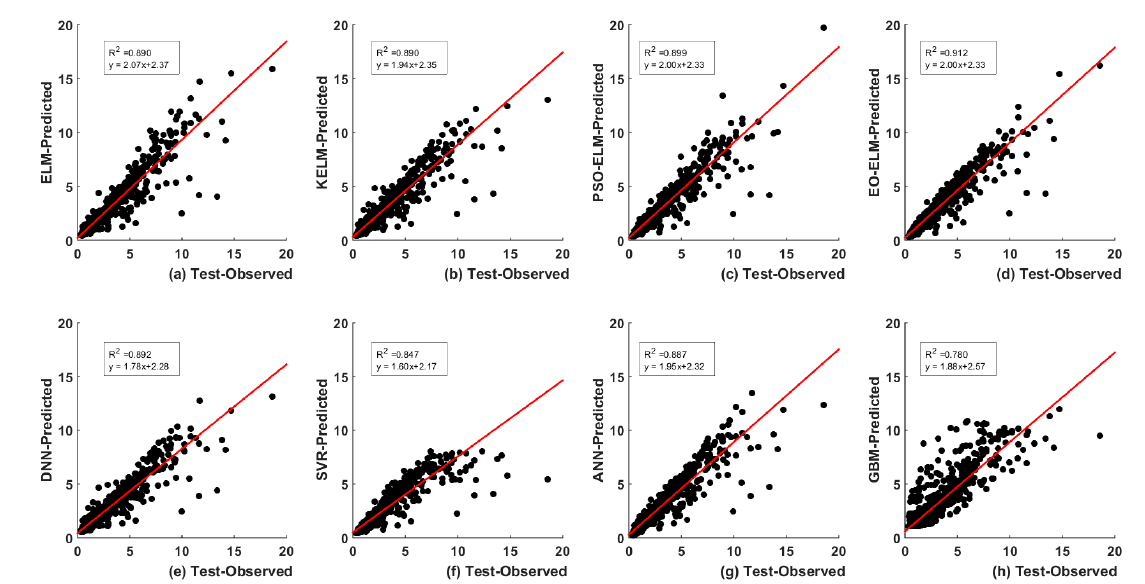
Figure 8. Prediction capability of the eight models in test case ( a ) ELM, ( b ) KELM, ( c ) PSO-ELM, ( d ) EO-ELM, ( e ) DNN, ( f ) SVR, ( g ) ANN, and ( h ) GBM for the catchment Fal at Tregony.